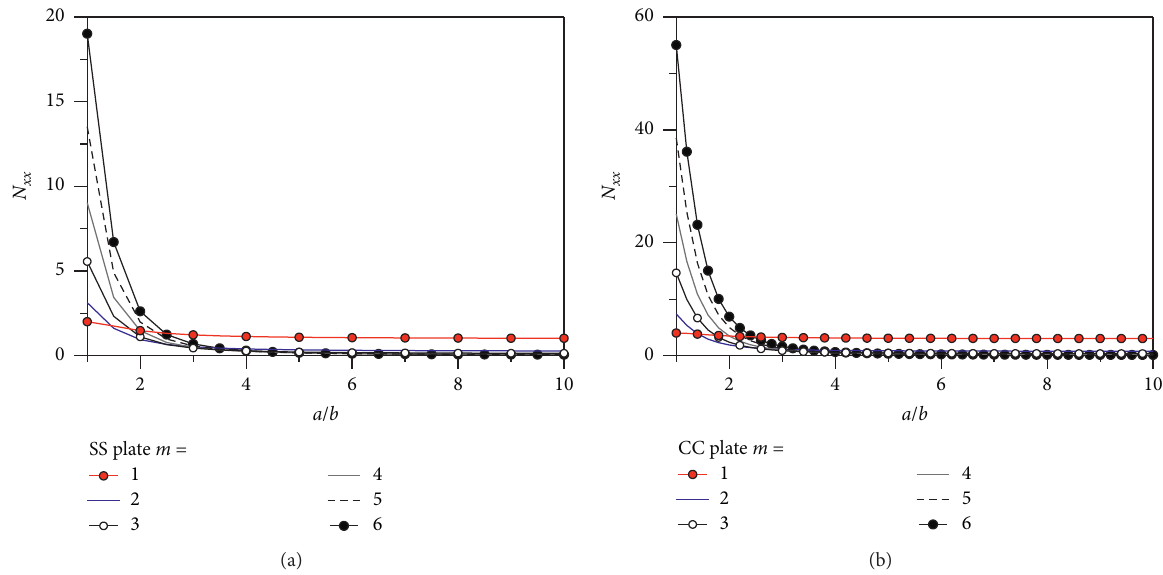
Figure 6: Variation of N xx as a function of a / b : (a) SS plates and (b) CC plates.